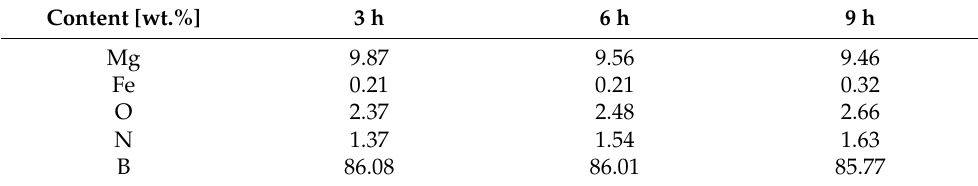
Table 2. The content of Mg/B2 composite powders cryomilled for 3 h, 6 h, and 9 h. Content